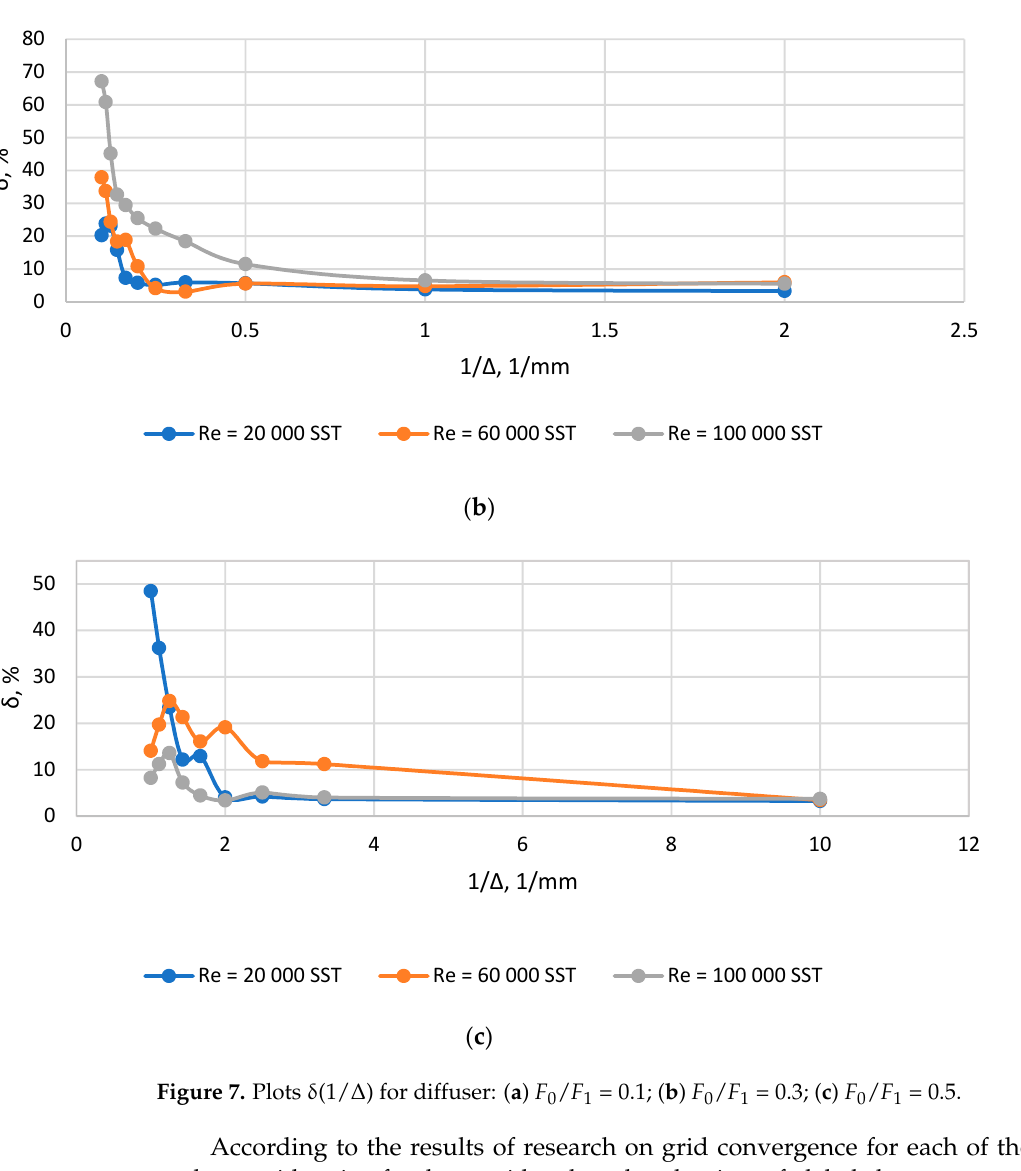
Table 4. Grid convergence data for the considered single channels. Sudden Expansion